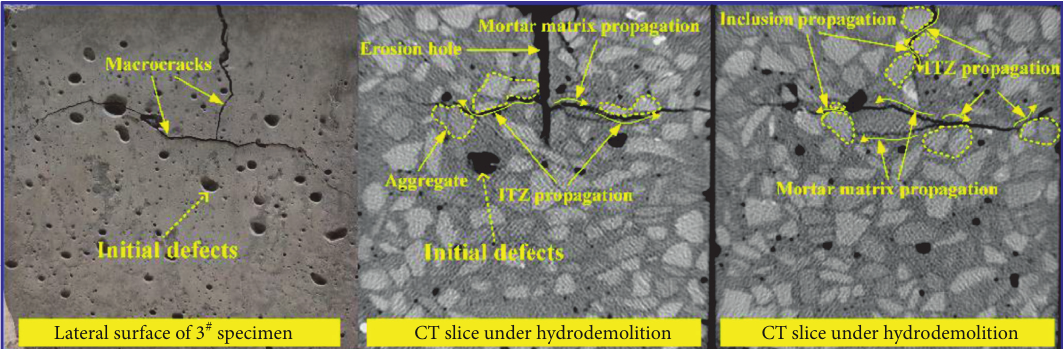
Figure 3: Crack propagation paths in the interior of concrete.